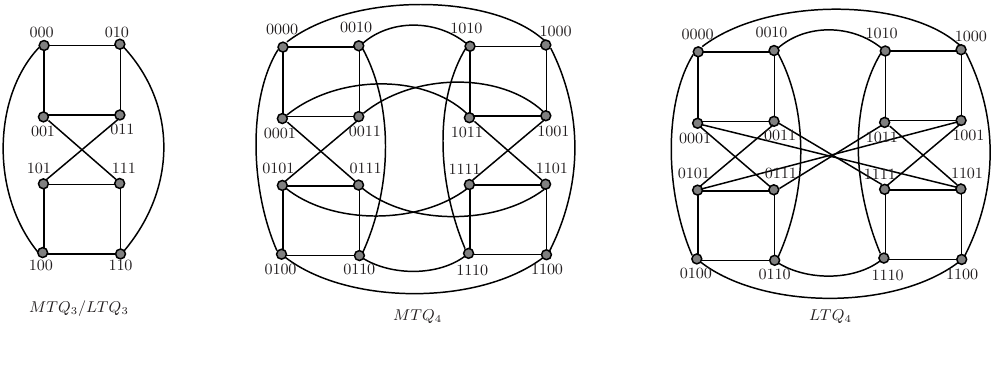
Fig.1 The multiply twisted cube and locally twisted cube when n = 3,